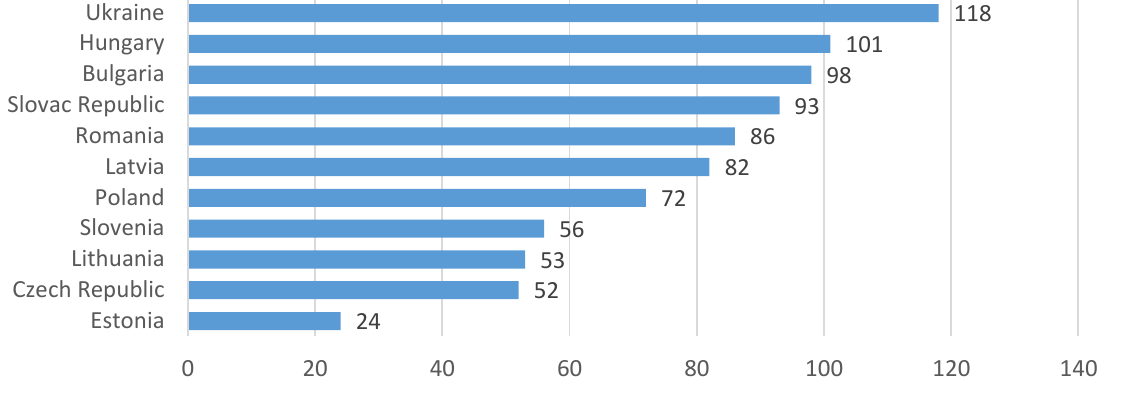
Figure 1. Place of Ukraine under the sub-index “Institutions”